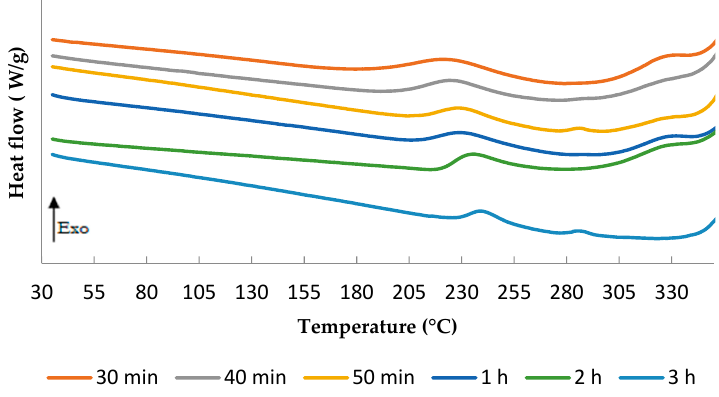
Figure 15. DSC scan of TETM/DDS formulations after various times of cure at 180 ˝ C, performed Figure 15 . DSC scan of TETM/DDS formulations after various times of cure at 180 °C, performed under nitrogen with a heating rate of 5 ˝ under nitrogen with a heating rate of 5 °C/min.